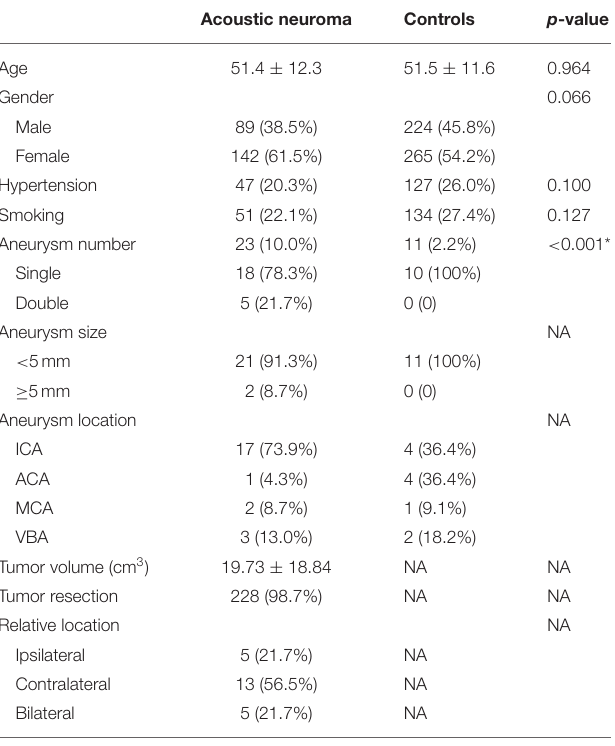
TABLE 1 | Summary of clinical features in patients with acoustic neuroma and age- and gender-matched controls.